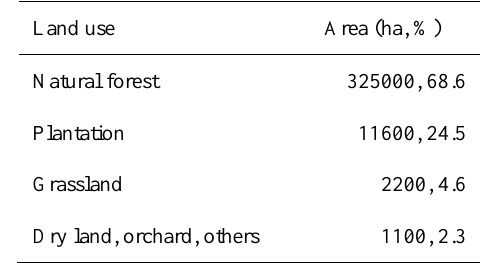
Table 1. Composition of land cover of the study area